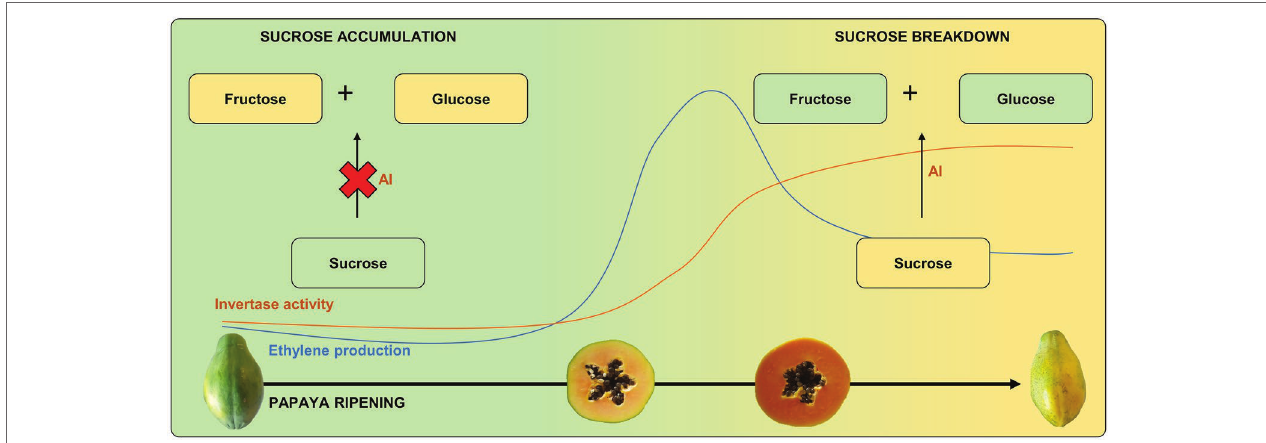
FIGURE 2 | Ethylene production and invertase activity during papaya ripening: papaya sucrose breakdown. Invertase activity is regulated by ethylene burst since sucrose is higher in unripe papayas or in papayas in which ethylene perception is blocked, with a subsequent increase in fructose and glucose after ripening/ethylene production. AI, acid